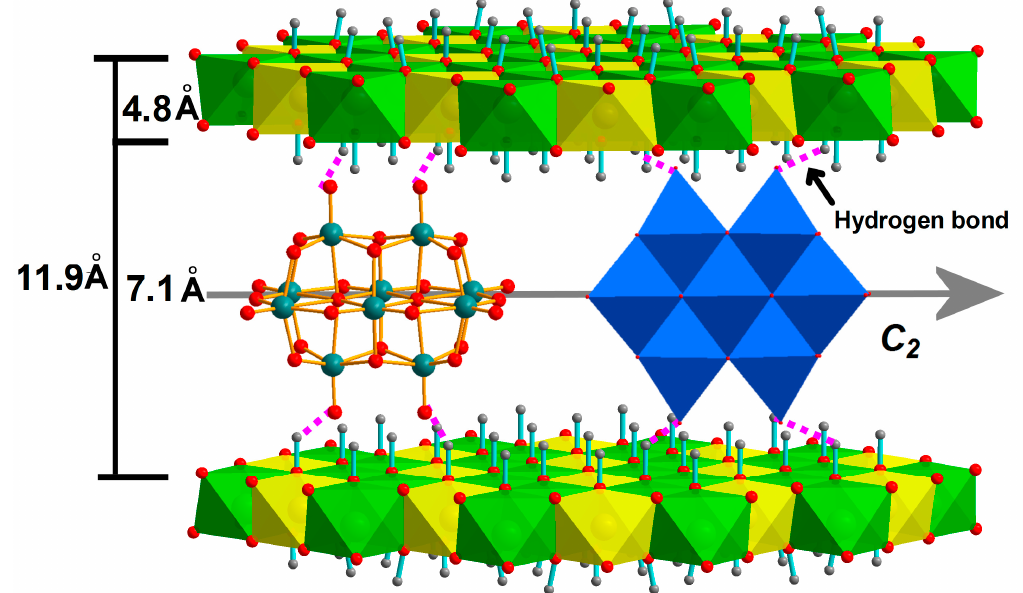
Figure 3. Orientation of decavanadate anion, V 10 O 286 − , in the interlayer region of layered double hydroxides, with its ‘main’ C 2 axis aligned parallel to the brucite ‐ like layers. Adapted from Ref. [12], Copyright 2014, Elsevier.